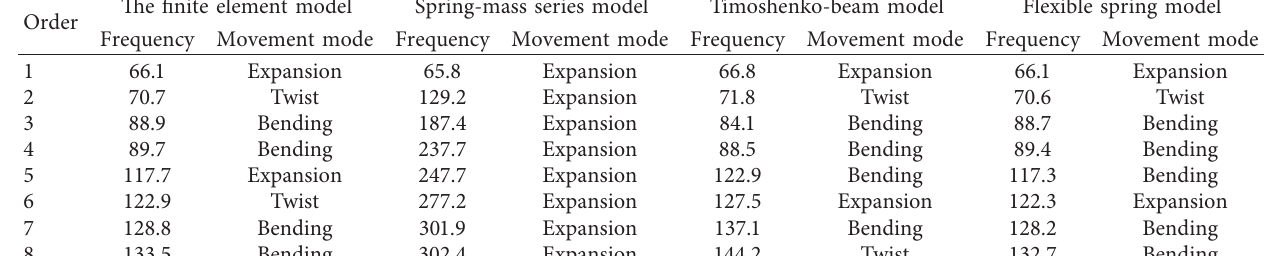
Table 6: The constrained modes of the coil spring.